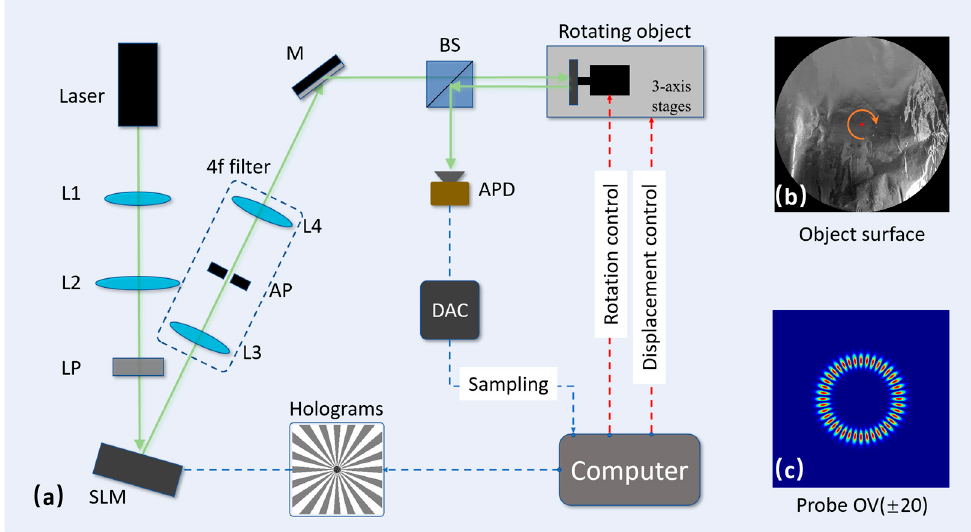
Figure 2. Experimental arrangement. ( a ) The experimental setup containing both the optical part and electric part. L1–L4: lenses (the focal lengths were: f1 = 30 mm, f2 = 100 mm, f3 = 50 mm, and f4 = 50 mm.) LP: linear polarizer; SLM: spatial light modulator; AP: aperture; M: mirror; BS: beam splitter; APD: avalanched photodetector; DAC: data-acquisition card. ( b ) The surface of the rotating object. A piece of silver paper covered the surface of the object to increase the intensity of the echo light. ( c ) The intensity profile of the probe beam with topological charge of ±